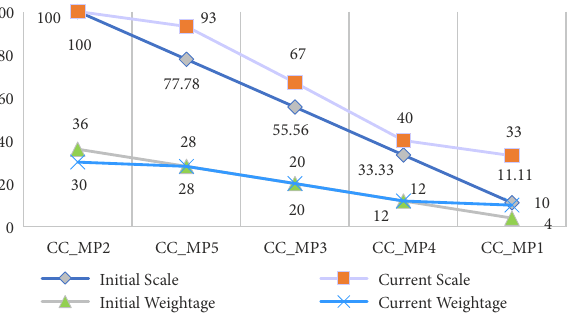
Figure A9. Model modification for sub-criteria of CFS Figure A10. Model modification for sub-criteria of FTR